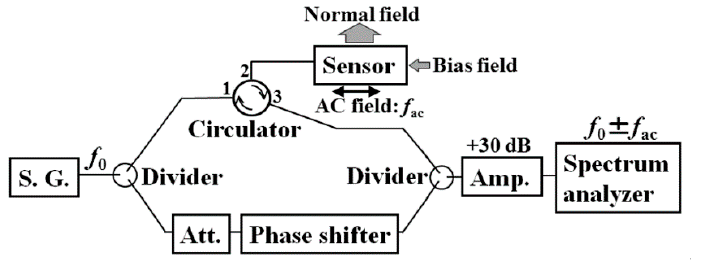
Figure 17. Block diagram of the carrier-suppressing circuit using reflection signal [21]. Table 1. Device list of the circuit.